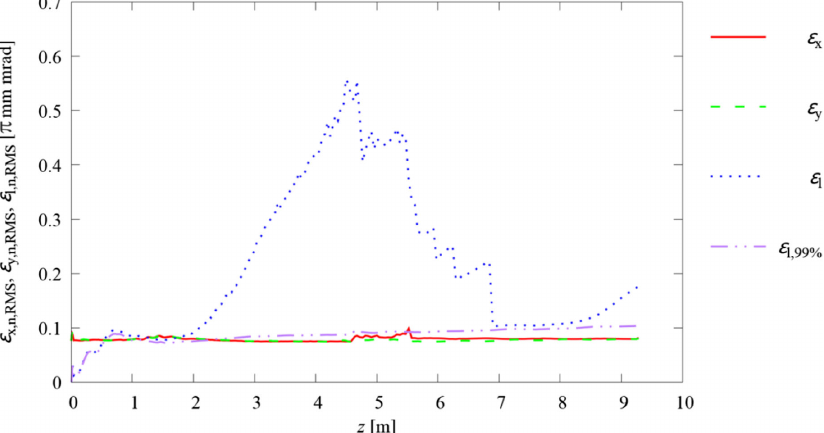
FIG. 5. Emittance evolutions along the linac (red, x plane; green, y plane; blue, longitudinal plane for all particles; purple, longitudinal plane for 99% of the beam).